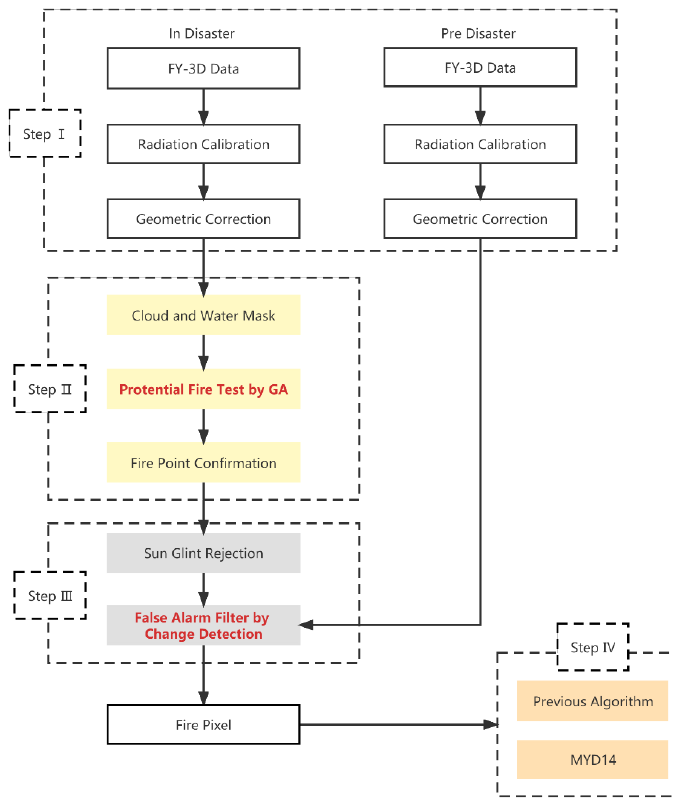
Figure 1. Flowchart of the proposed detection algorithm in this paper.